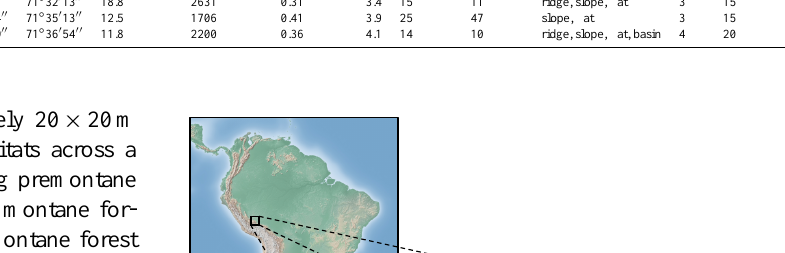
Table 1. Site characteristics. KosñipataValley Chambers (ma.s.l.)